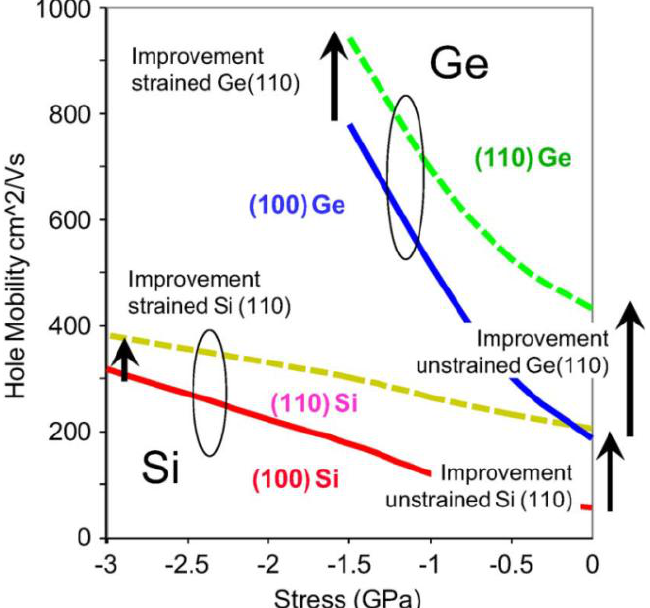
Figure 1. Hole mobility of Si and Ge as a function of stress and wafer orientation. Ge offers both better intrinsic hole mobility and better scalability compared to Si, reprinted with permission from [20]. Copyright 2012,